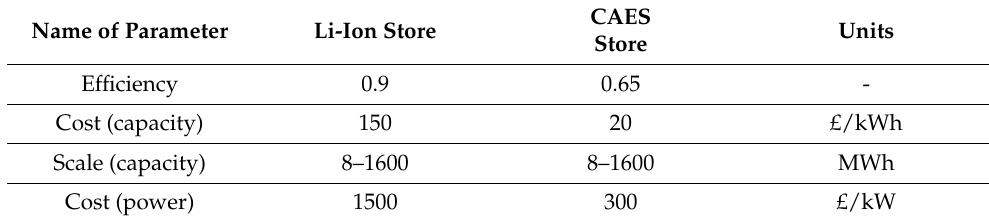
Table 5. Efficiencies and costs of the other wind–storage systems. Costs estimated from [49,50].